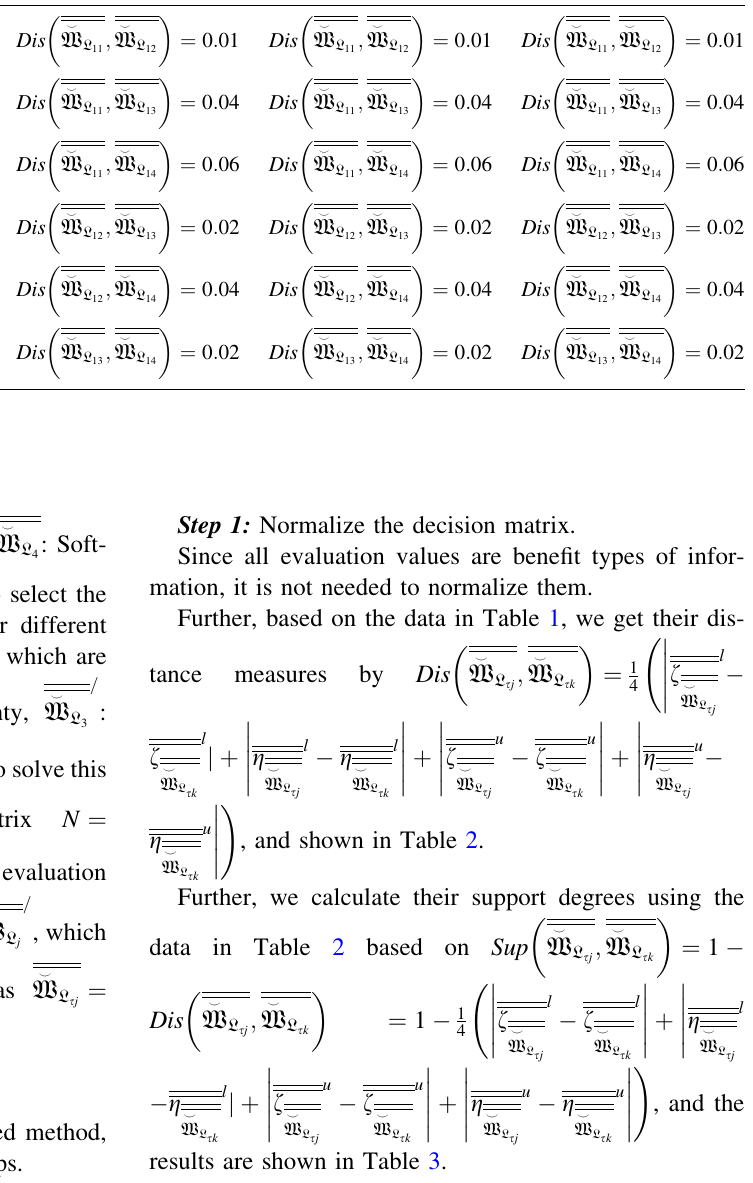
Table 2 The distance measures